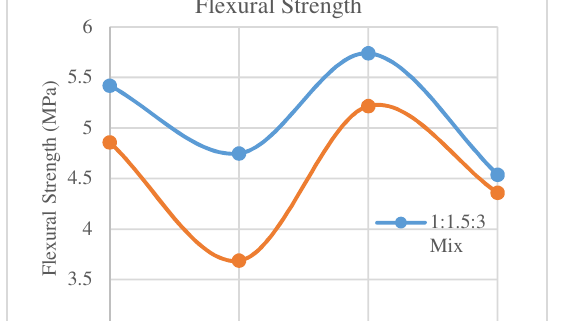
TABLE 5. FLEXURAL STRENGTH TEST RESULTS AT 1:1.5:3 MIX